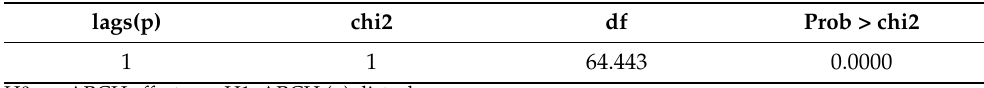
Table 6. LM test results for autoregressive conditional heteroskedasticity (ARCH). lags(p)